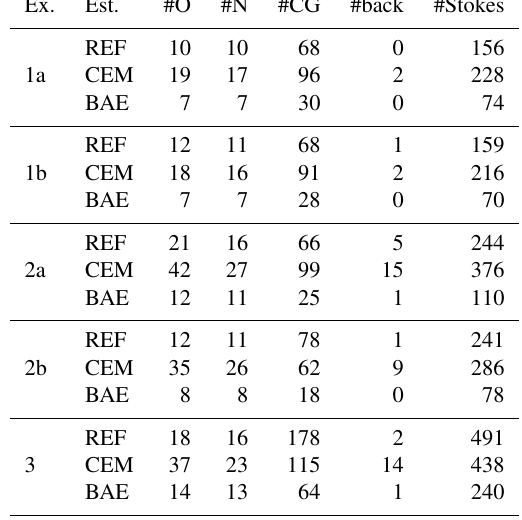
(b) . (c, MAP (c) and the MAP (d) . The dashed MAP